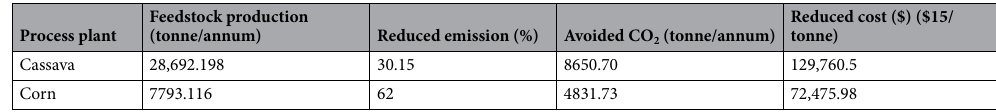
Table 14. Feedstock production phase